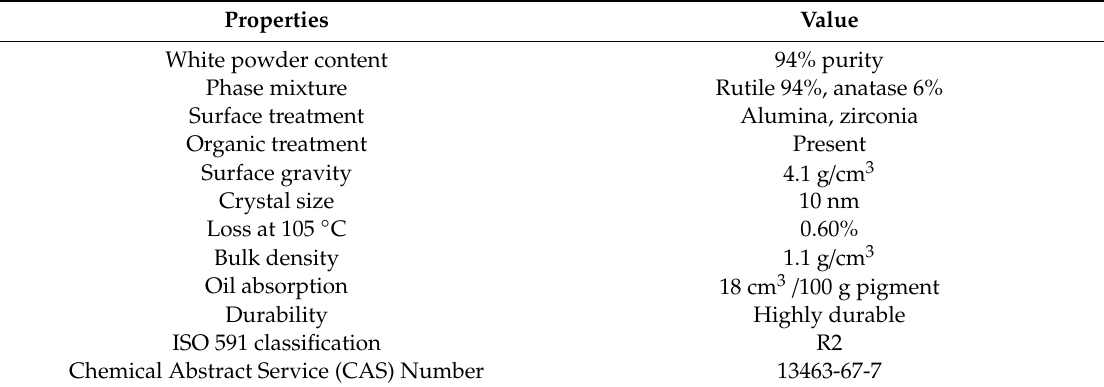
Figure 2. Process flow diagram for this study.